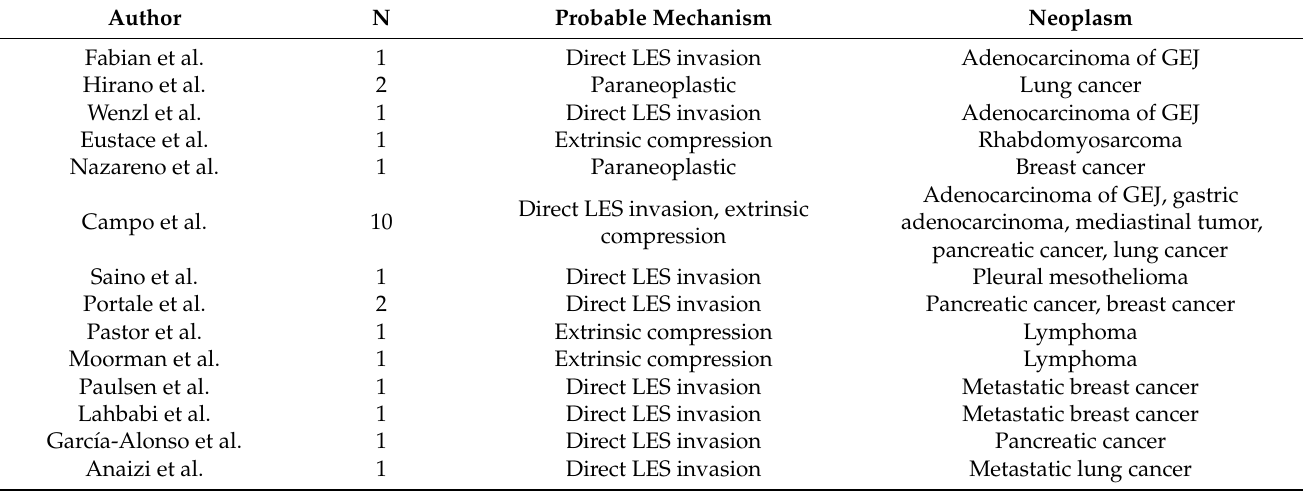
Table 2. Pseudoachalasia secondary to malignancy. Main